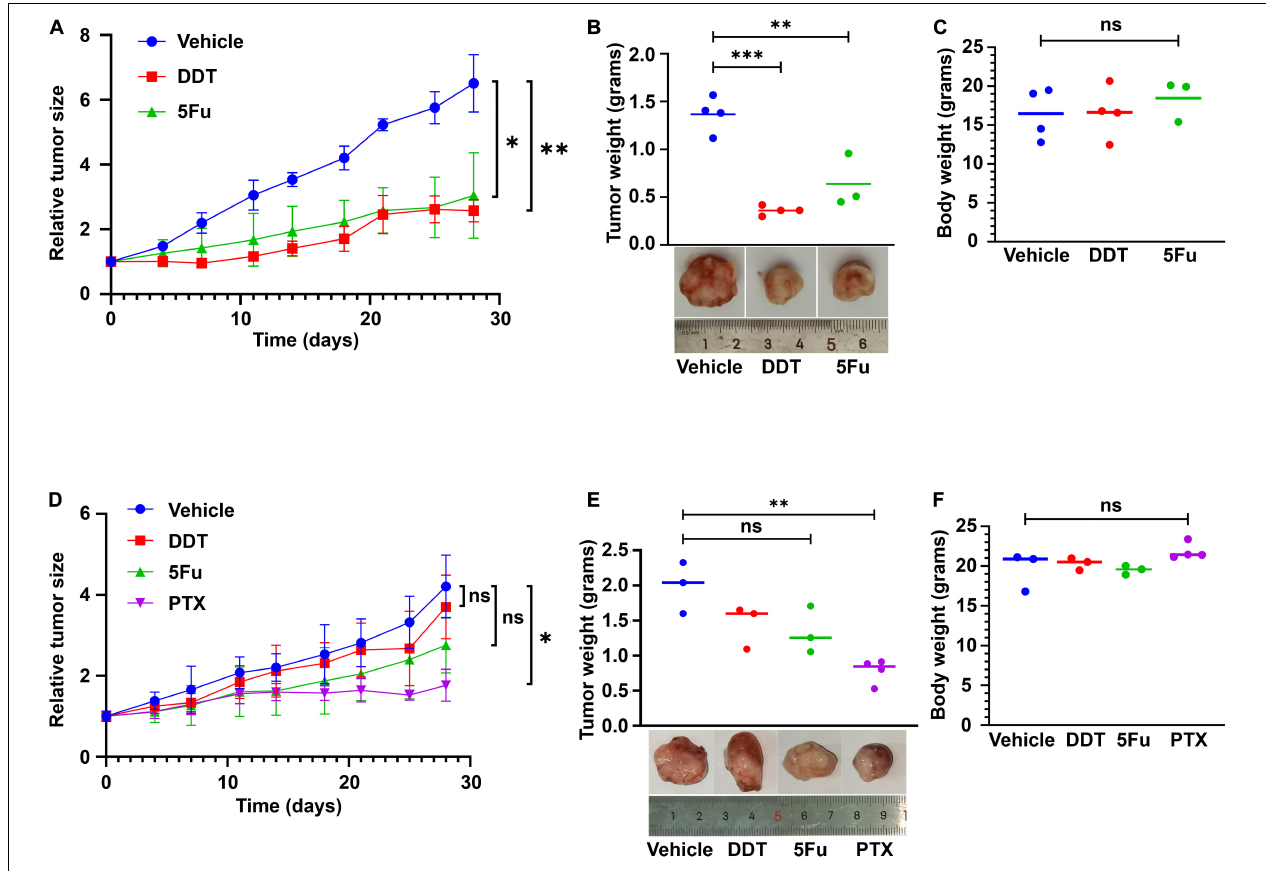
FIGURE 4 | CR cell-derived xenografts used for drug testing. (A) T2 cell-derived xenografts were treated with vehicle control, cisplatin (DDT), and 5FU beginning from the same day after grouping for 4 weeks. Tumor sizes were measured as indicated. Mean ± SEM ( n ≥ 3) was measured. (B) The tumor weight at the end of the treatment was plotted. Representative images of the tumor were presented. (C) Mouse body weights were also compared, with no significant difference. (D) T6 cell-derived xenografts were treated with vehicle control, DDT, 5FU, and paclitaxel (PTX) beginning from the same day after grouping for 4 weeks. Tumor sizes were measured as indicated. Mean ± SEM ( n ≥ 3) was measured. (E) The values of tumor weight at the end of the treatment were plotted. Representative images of the tumor were presented. (F) Mouse body weights were also compared, with no significant difference. ∗ P < 0.05, ∗∗ P < 0.01, ∗∗∗ P <